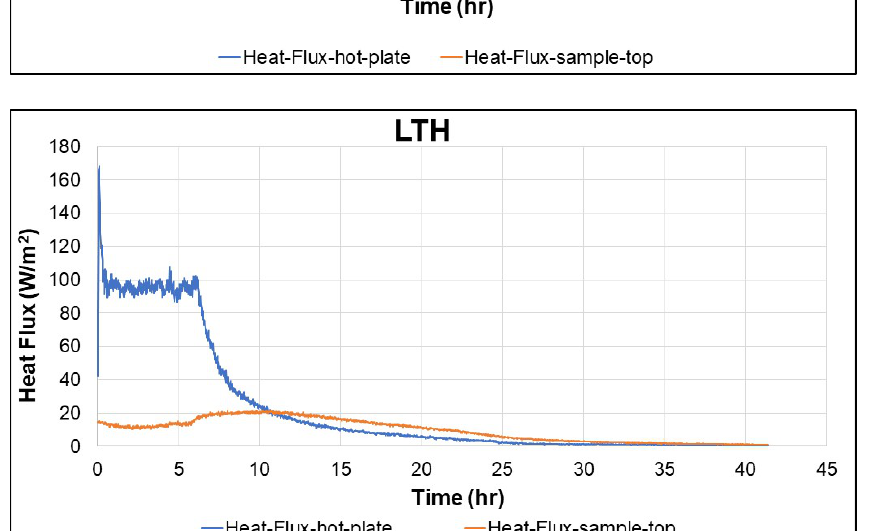
Figure 8. Heat flux variation for three different thermal systems for concrete samples.